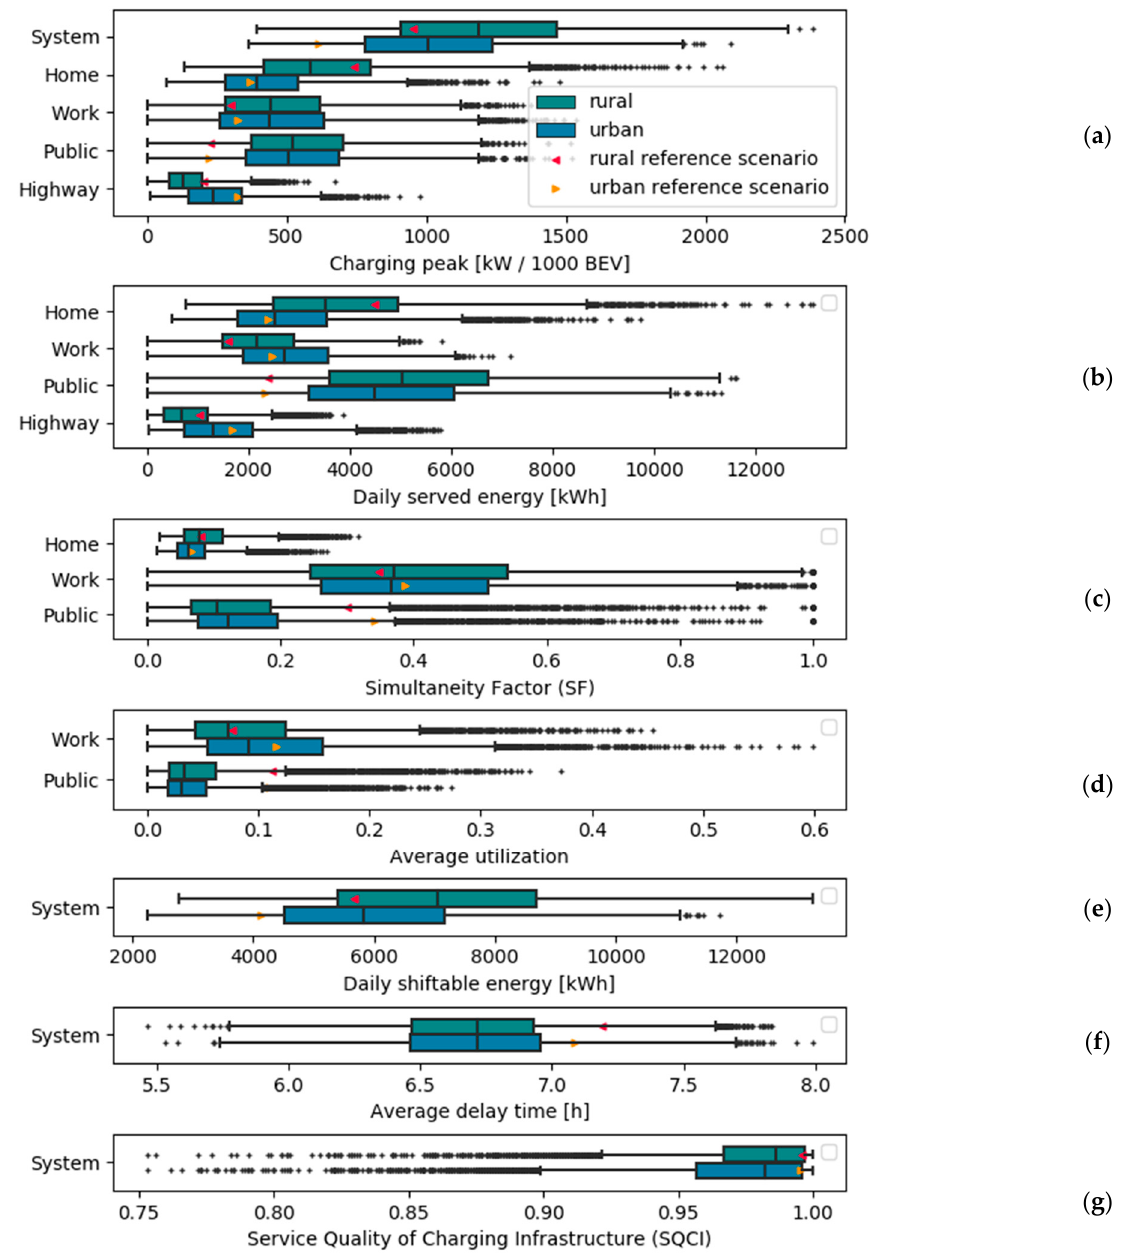
Figure 5. This plot shows the possible range of key e-Mobility output parameters resulting from 8800 simulations in the course of the global sensitivity analysis as well as the comparison of the potential output variations to the parametrized rural and urban reference case. The subfigures show ( a ) the charging peak 1000 BEVs, ( b ) the daily served energy, ( c ) the simultaneity factor, ( d ) the average utilization of work and public CS, ( e ) the daily shiftable energy within the region, ( f ) the average delay time of shiftable energy and ( g ) the SQCI. The values in ( a , b , e ) are normed to 1000 BEVs. All subfigures show box plots with whiskers; outliers are defined by factor 1.5 times the interquartile range past the low and high quar- tiles.